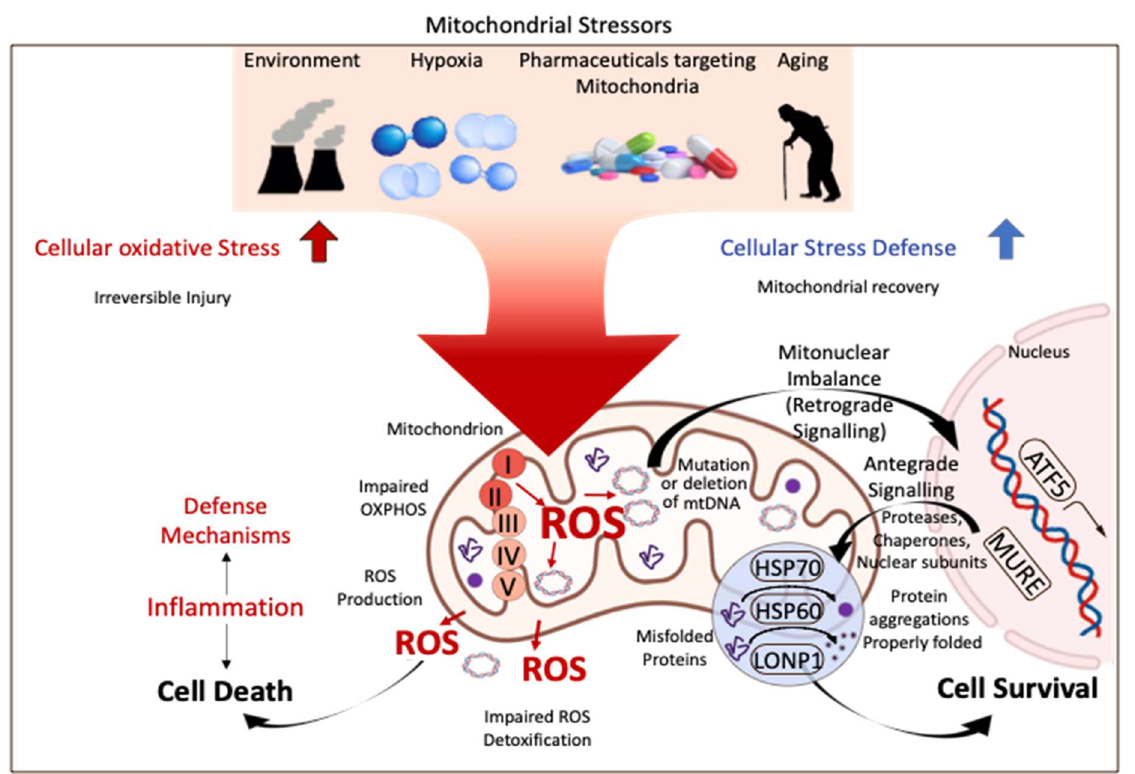
Figure 1. Mitochondrial stress response and signaling in injury and disease. Mitochondria are key compounds in all cells and balance injury with resilience to defend cells from stress induced by the environment, related to ageing, or from hypoxia. Mitochondria are therefore crucial for cells and organs to survive the process of donation, preservation, and transplantation. ROS: reactive oxygen species; ATF 5: activating transcription factor; HSP 60/70: heparan sulfate 60/70; LONP1: Lon pep- tidase 1. This figure was designed with the support from biorender.com (accessed on 15 June 2022). When a donor is available, a certain level of tissue hypoxia always occurs and triggers an overall impaired metabolism. The mitochondrial metabolism is always impaired to a certain extent and prompts the well-known cascade of ischemia-reperfusion injury (IRI) when oxygen becomes available again (reperfusion). The main feature is a pro-inflamma- tory cascade, which leads to more or less clinical post-transplant complications based on the overall organ quality and function. One direct consequence after reperfusion is the